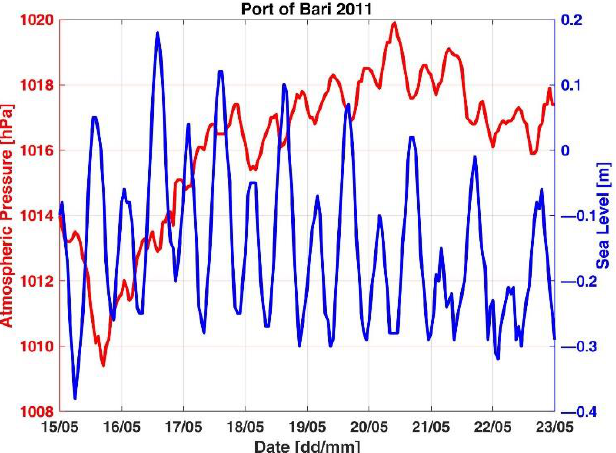
Figure 9. Meteomareographic parameters acquired by ISPRA’s monitoring station in the port of Bari from 15 to 23 May 2011.